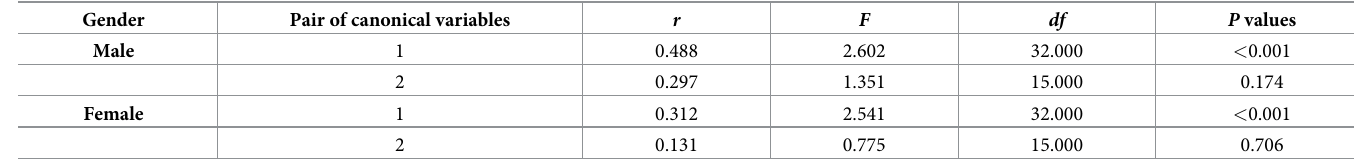
Table 2. 16PF factors (psychological feature, A-Q4 )’s correlation to fWHR and average bilateral mandibular line angle (facial morphology feature).